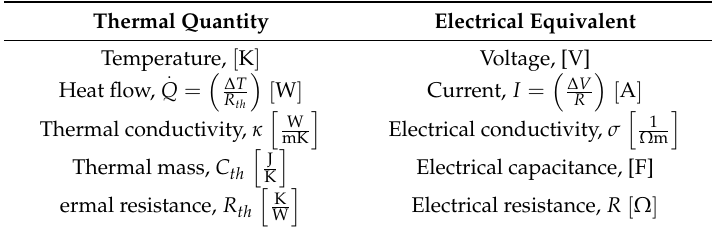
Table 1. Analogy between thermal and electrical parameters in this study.